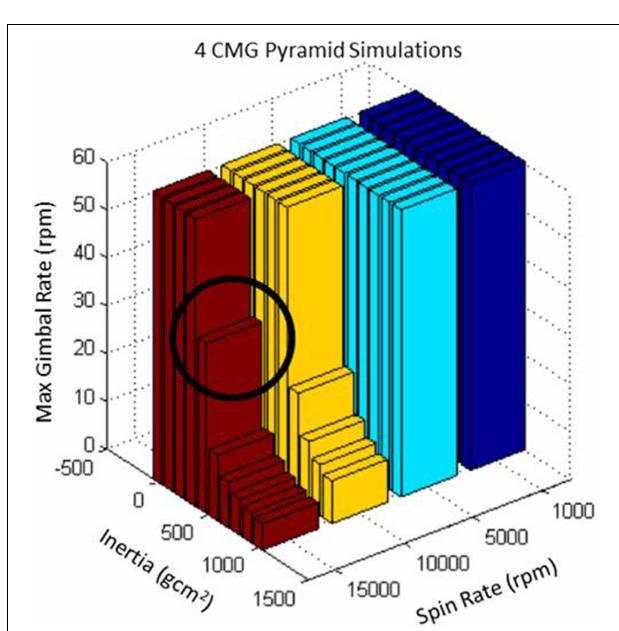
FIGURE 4 | SGCMG simulation architecture to select an array for the V2Suit. The inputs to the simulation are the direction of the torque vector in the module coordinate frame (determined by